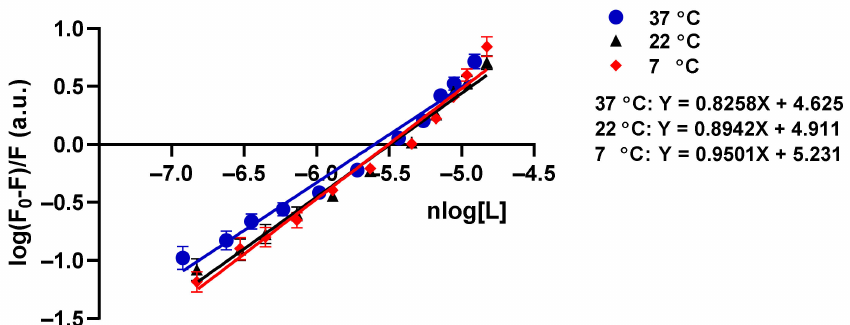
Figure 7. The Hill plots and intrinsic tau protein quenching constants of tau-CBD interaction at 7 ◦ C, 22 ◦ C, and 37 ◦ C. Hill plot of tau protein fluorescence quenching at different concentrations of CBD from 0–14.9 µ M (0 µ M, 0.45 µ M, 1.3 µ M, 2.3 µ M, 4.5 µ M, 6.7 µ M, 10.9 µ M, and 14.9 µ M) at three different temperatures of 7 ◦ C, 22 ◦ C, and 37 ◦ C. All data points are given as the mean ± SD of three independent experiments ( n = 3). Table 3. Intrinsic tau protein quenching constants of tau-CBD interaction at 7 °C, 22 °C and 37 °C obtained from the modified Stern–Volmer equation (4) and Hill equation (7).